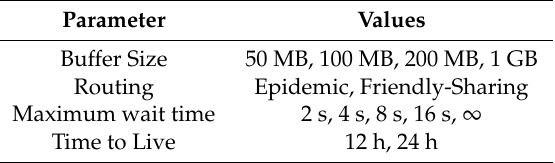
Table 4. Simulation parameters varied to evaluate diffusion approaches.